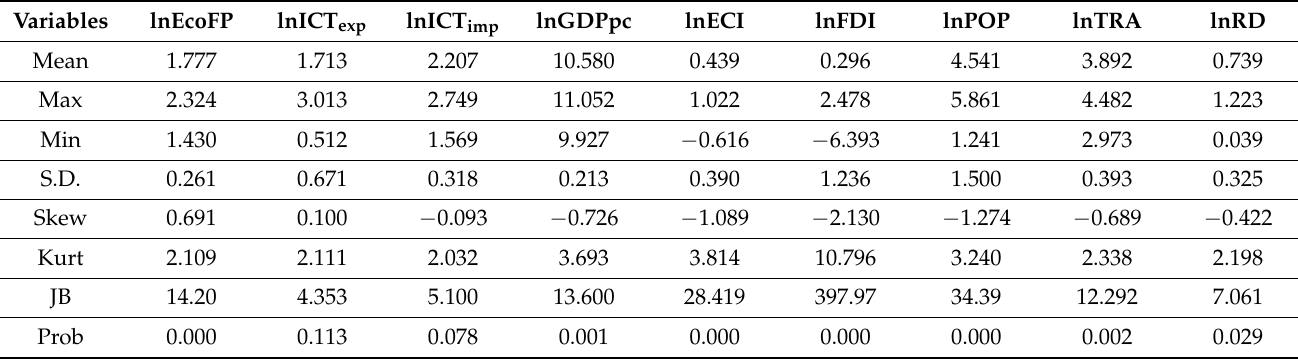
Table 2. Summary statistics of the